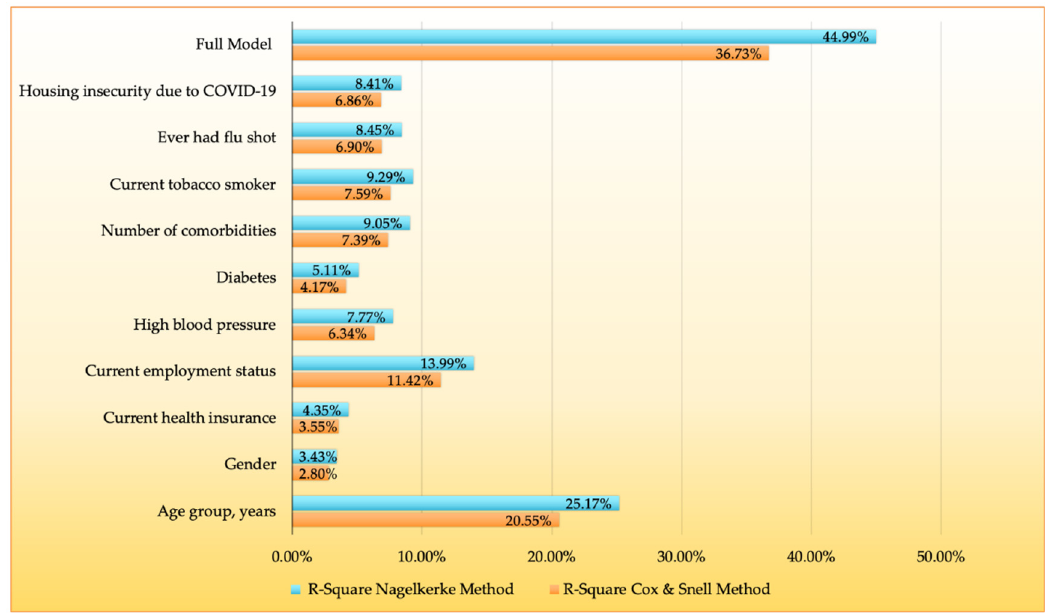
Figure 3. Results for R 2 (presented as percentages) values for independently fit models and full model using the polytomous logistic regression, among 257 community participants within the SPARTA and 100 Black Men of Augusta survey by vaccine hesitancy groups.